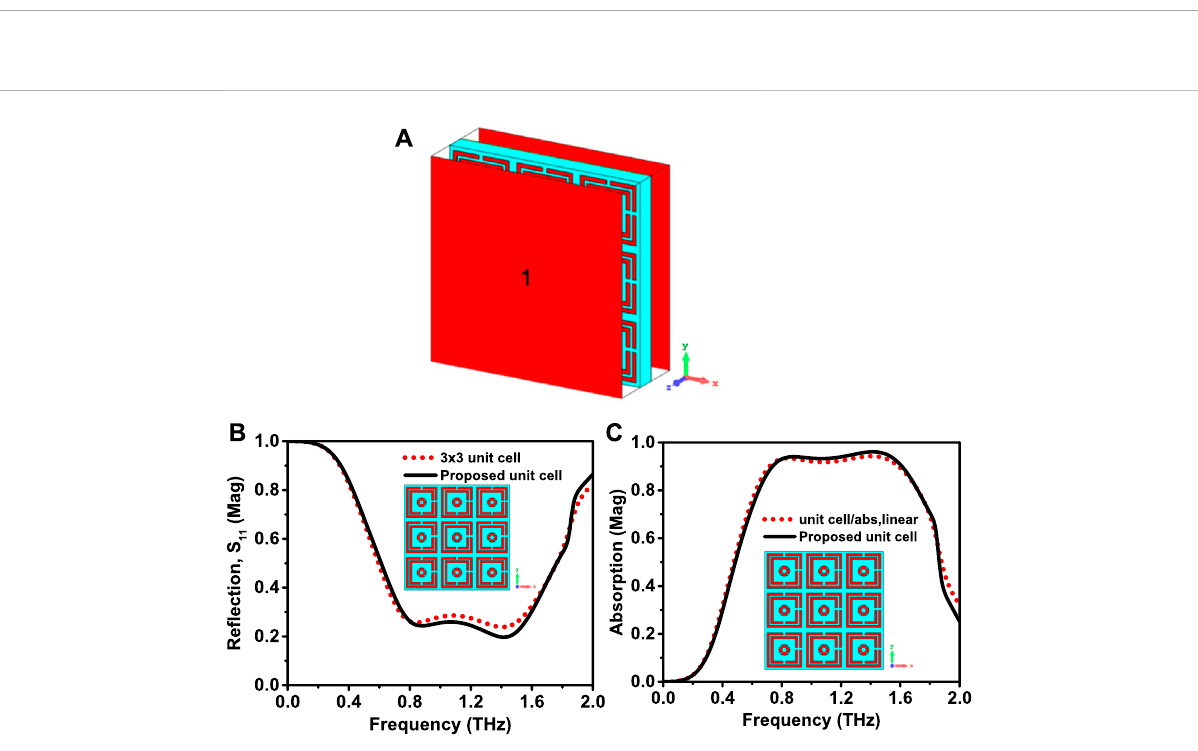
FIGURE 17 (A) 3 × 3 array simulated design, (B) its re fl ection and (C) absorption